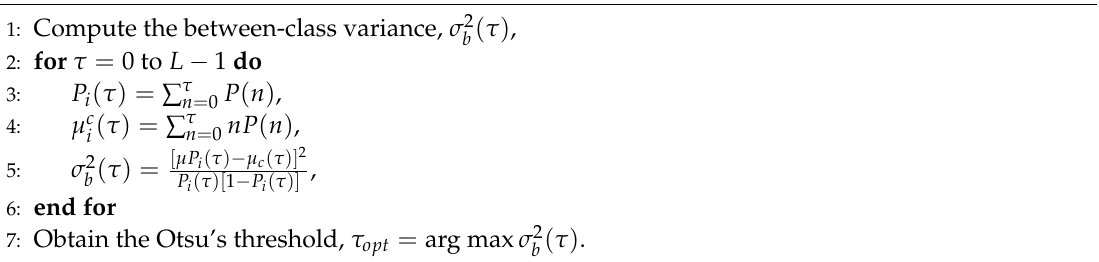
Algorithm 2 The fast Otsu’s algorithm.